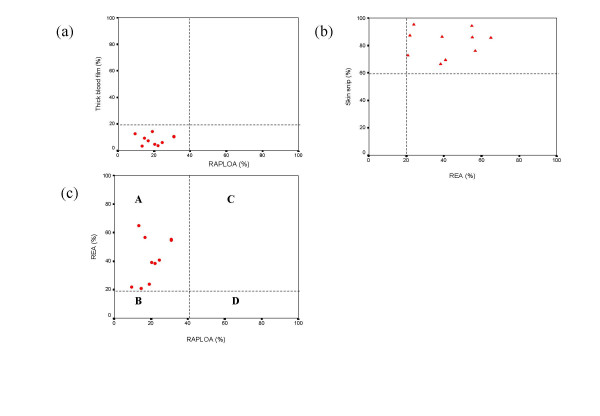
a: Relationship between the RAPLOA and L. loa microfilaraemia prevalences. Dotted lines represent the thresholds levels above which there is increased risk of neurologic SAEs. b Relationship between the REA and the microfiladermia prevalences. Dotted lines represent the thresholds levels above which mass treatment with ivermectin is most urgent (microfiladermia) or highly desirable (REA). c Relationship between RAPLOA and REA prevalences. A: Large-scale treatment with low risk of neurologic SAEs; B: Large scale treatment with high risk of neurologic SAEs; C: No large-scale treatment with ivermectin D: No large-scale treatment with ivermectin. Dotted lines represent the thresholds levels above which the risk of neurologic SAEs is high